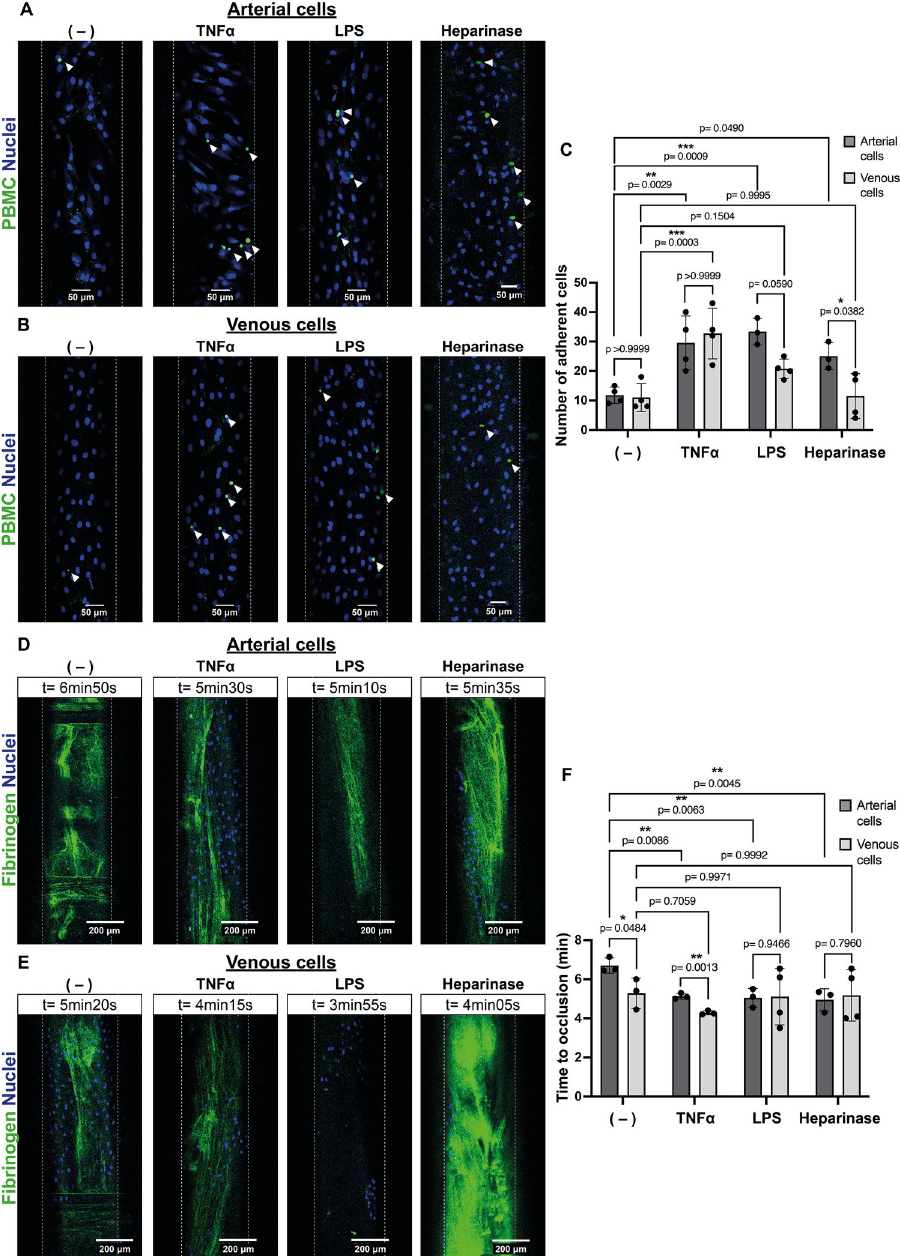
Figure 5. Intact heparan sulfate on TNFα or LPS activated venous endothelial cells does not impede leukocyte adhesion but protects against clot formation. ( A , B ) Representative images of three time-lapse recordings of binding of porcine peripheral blood mononuclear cells (PBMCs; shown in green) to ( A ) arterial and ( B ) venous porcine endothelial cells left untreated (−) or perfused with either 100 ng/ml TNFα, 100 μg/ml LPS or 5 U/ml heparinase (Heparinase). Nuclei of cells are shown in blue (Hoechst). Scale bar: 50 μm. ( C ) Adherent PBMCs were quantified from 20 min time-lapse recordings of four independent experiments by counting cells immobilized for ≧ 3 s. ( D , E ) Representative images of fibrin clots (green) forming on ( D ) arterial or ( E ) venous porcine endothelial cells. Cells were left untreated (−) or perfused with either 100 ng/ml TNFα, 100 μg/ml LPS or 5 U/ml heparinase (Heparinase). Nuclei of cells are shown in blue (Hoechst). Scale bar: 200 μm. ( F ) Time to occlusion was determined as complete channel occlusion or cell detachment and quantified from time-lapse recordings of plasma perfused channels spiked with AlexaFluor488 labeled fibrinogen (green). Data are from four independent experiments, 2–3 different porcine ECs donors and were analyzed using Fiji software. ( C ) Two-way ANOVA with Tukey and Bonferroni post-hoc test or ( F ) one-way ANOVA with multiple comparisons was used for statistical